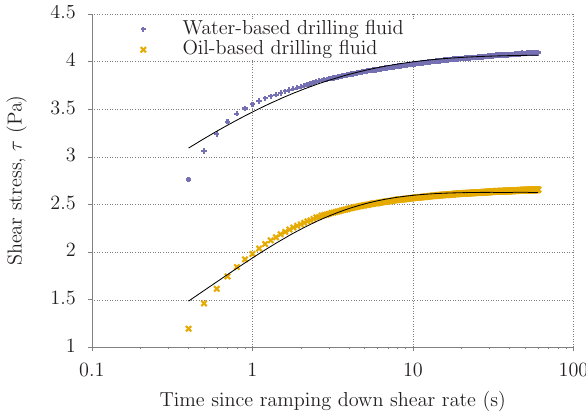
Figure 6: Thixotropic response in the two drilling fluid systems to stepping down the shear rate from 170.2 s −1 to 5.1 s −1